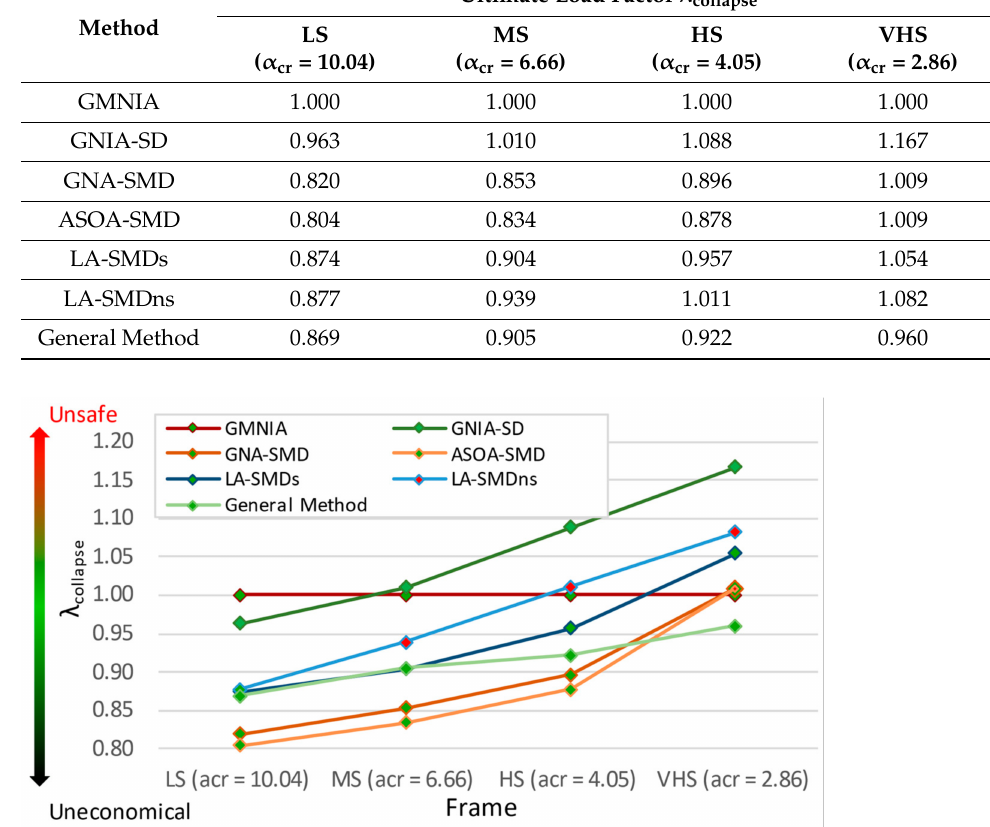
Figure 11. Ultimate load